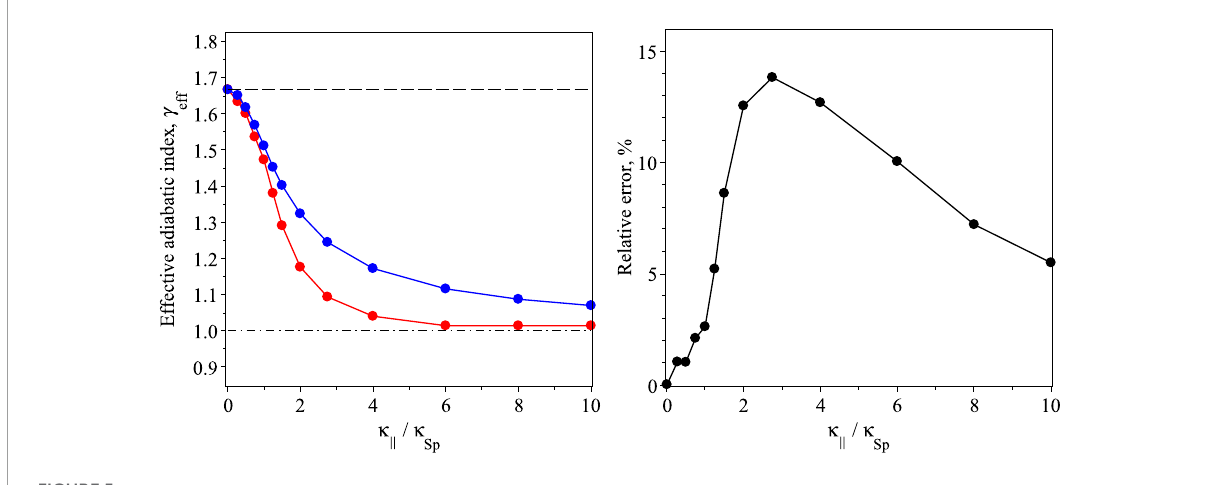
FIGURE 5 The dependence of the effective adiabatic index γ eff of the coronal plasma on the field-aligned thermal conduction coefficient κ ‖ (left), estimated numerically as ratio of the effective slow wave speed to the standard sound speed (red), see Eqs 7 , 8 , and under the polytropic assumption (blue) with Eq. 9 . The horizontal dashed and dot-dashed lines indicate the values of γ eff in the ideal adiabatic case (5/3) for low κ ‖ and in the isothermal regime (1) for high κ ‖ , respectively. The right panel shows the relative error between the estimations of γ eff , shown in red and blue in the left